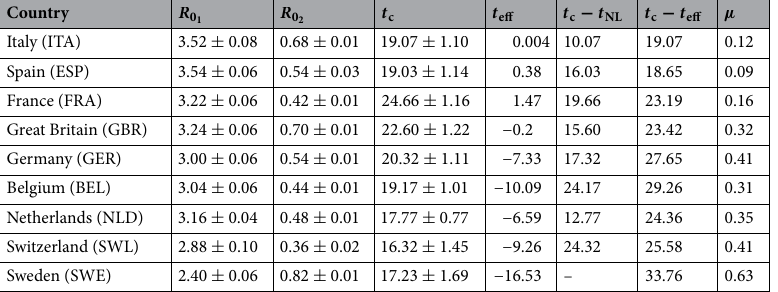
Table 1. Key parameters of the daily COVID-19 death toll and social distancing. Parameter values correspond to mean ± SE; see also Supplementary Tables 1–3.